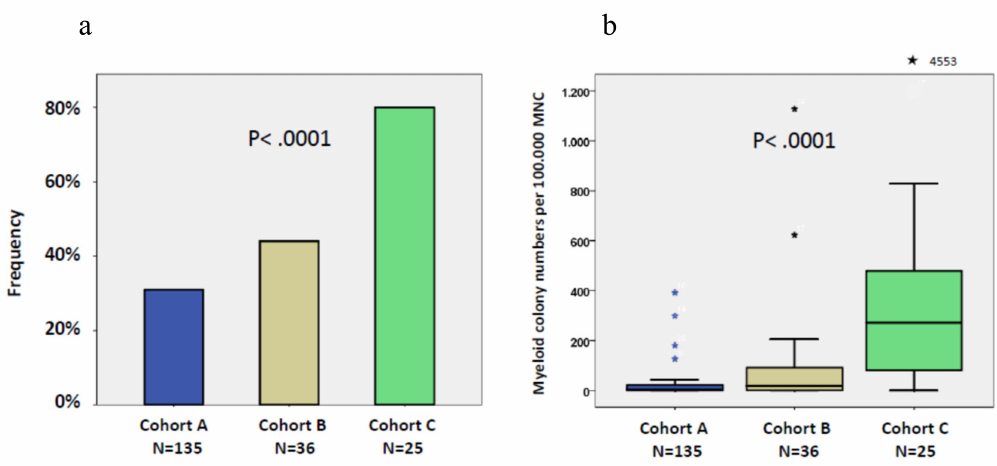
Figure 5. ( a ) Frequencies of high spontaneous myeloid colony formation ( > 20 / 10 5 peripheral blood mononuclear cells (PBMNC)) in patients without evidence of progression (cohort A), patients who developeddiseaseprogression(transformationand / ordisease-relateddeath)duringfollowup(cohortB), and patients who had already transformed to secondary AML at the time of sampling (cohort C). Cohort C includes 13 patients from cohort B who initially had no evidence of transformation but developed AML during observation. ( b ) Box plots showing the distribution of spontaneous colony numbers in the 3 patient cohorts including median values, minimum values, maximum values, as well as upper and lower quartiles, respectively. Cultures were plated in duplicates or triplicates, respectively, at 25–100 × 10 3 PBMNC / mL. Aggregates with more than 40 translucent, dispersed cells were counted as CFU-GM. CFU-GM data from patients are expressed as mean values from